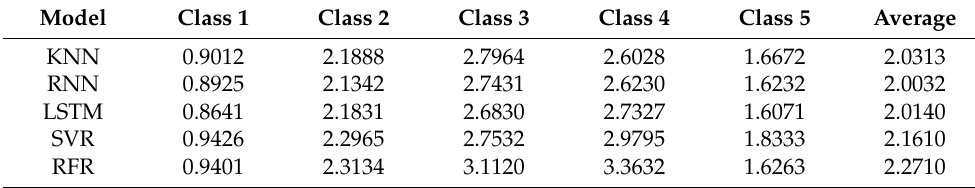
Table 6. Validation results (MRE%) for every single prediction